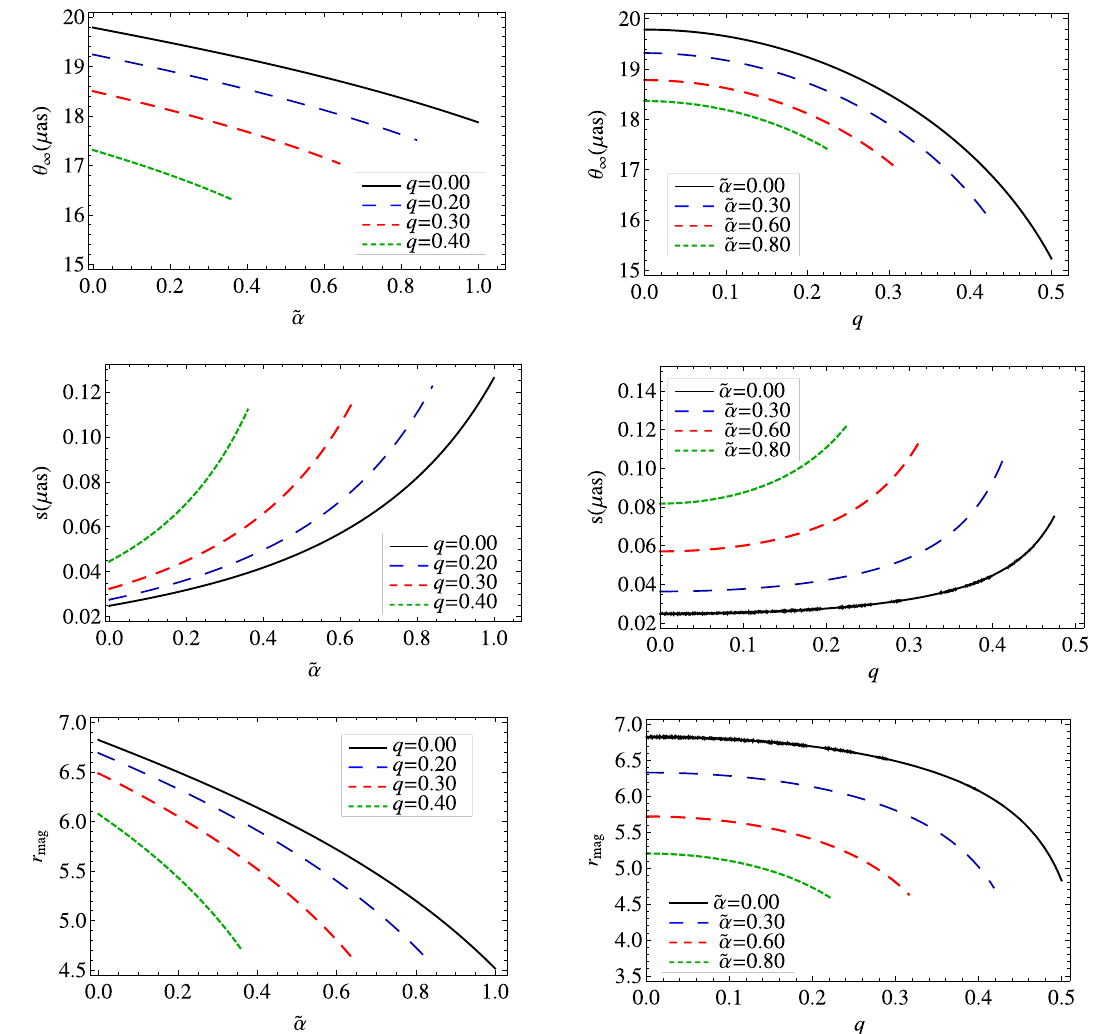
Fig. 10 Plots showing the behavior of strong lensing observables θ ∞ , s , and r mag as a function ˜ α (Left panel) and q (Right panel) for M87* black